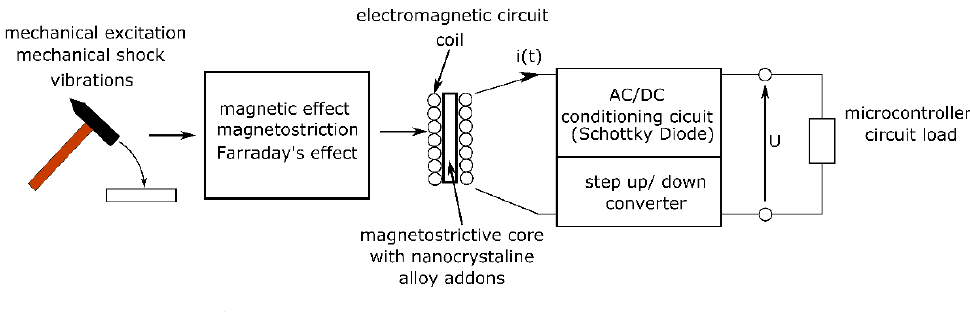
Figure 1. Harvester scheme.